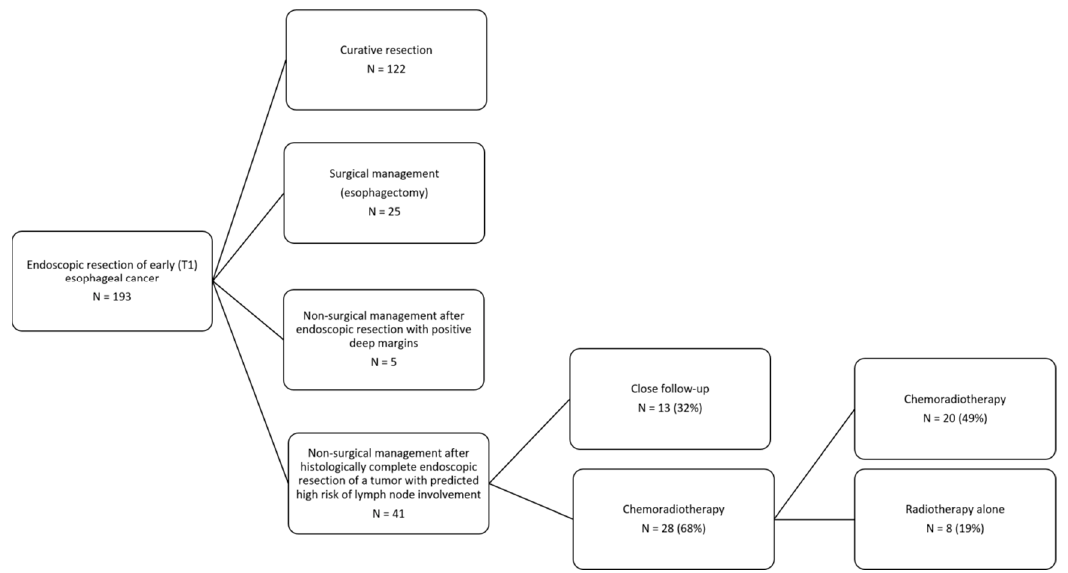
Figure 1. Patients Figure 1. Patients flowchart.